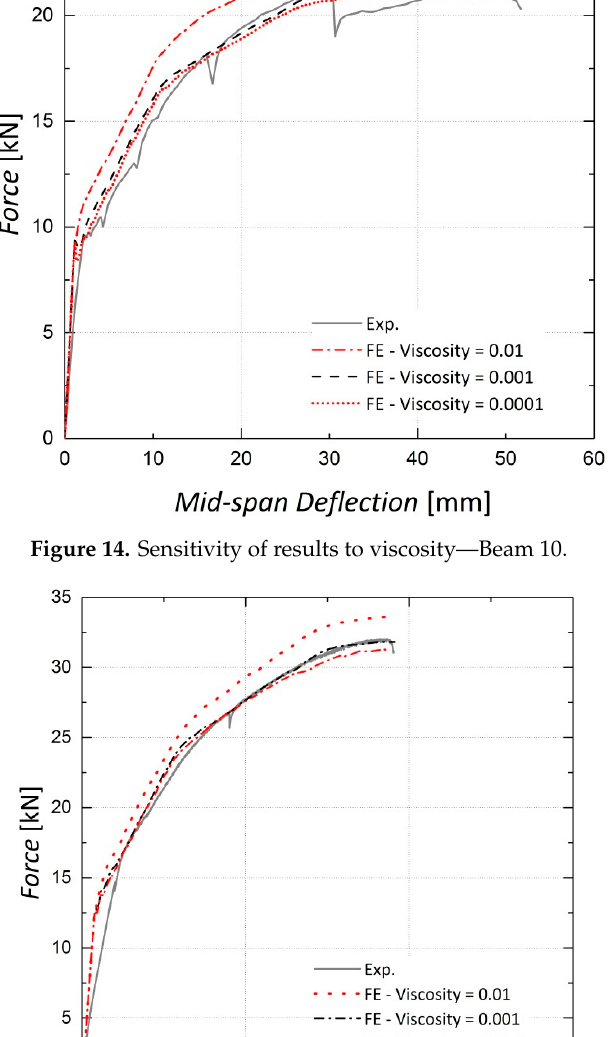
Figure 15. Sensitivity of results to viscosity—Beam 11.